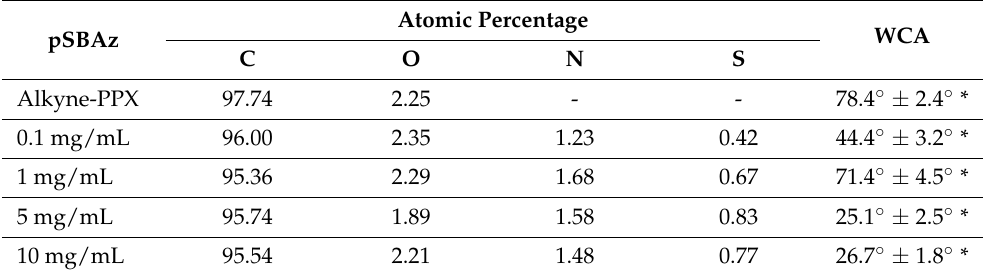
Table 1. The atomic compositions and water contact angle (WCA) of Alkyne-PPX and pSBAz conjugated Alkyne-PPX.